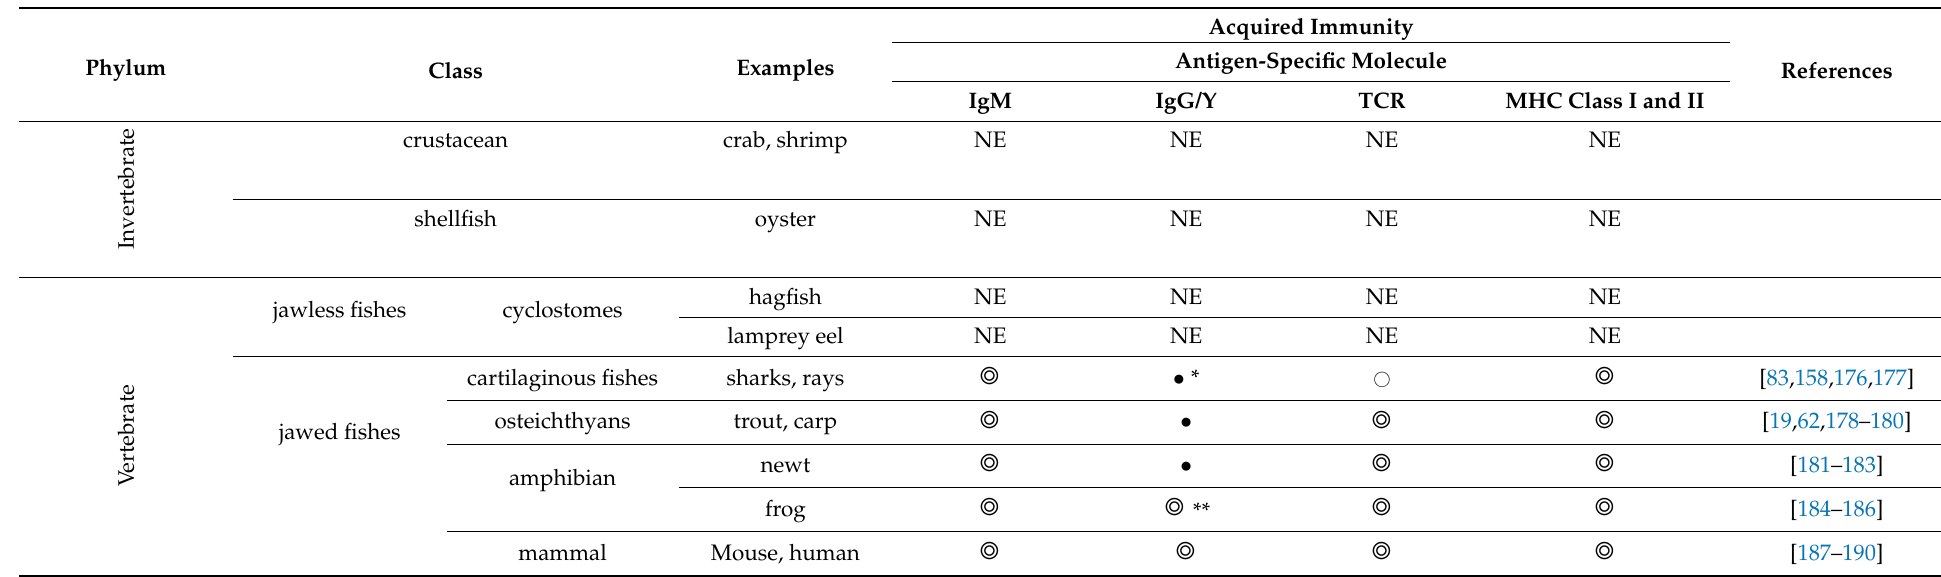
Table 6. Comparison among aquatic organisms of antigen-specific molecules in acquired immune systems.